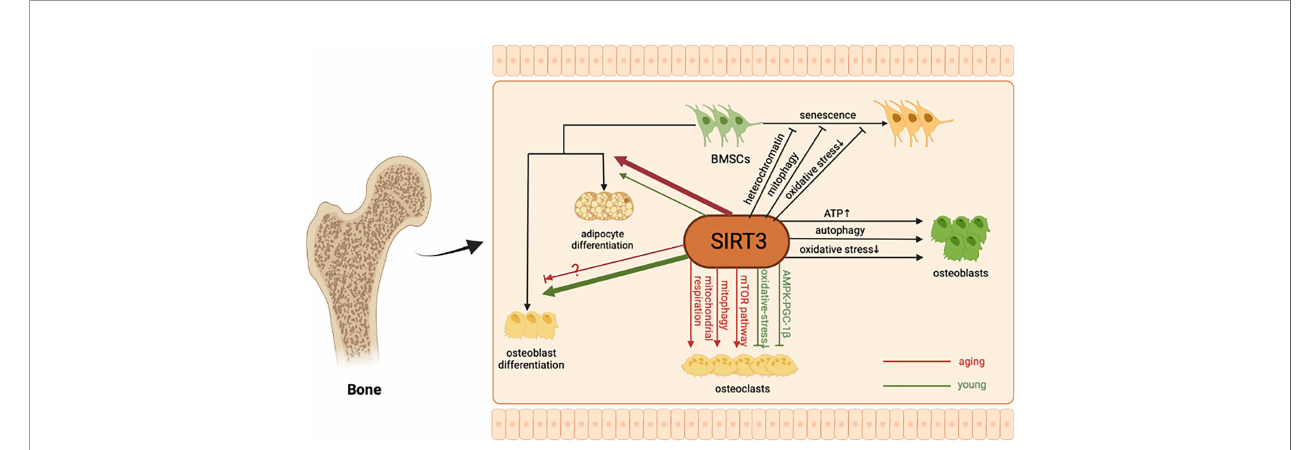
FIGURE 1 | The molecular mechanism of SIRT3 in bone remodeling. As a major mitochondrial protein deacetylase, SIRT3 can alleviate BMSCs senescence by regulating oxidative stress, mitophagy, and stabilizing heterochromatin. In addition, SIRT3 could protect osteoblasts and promote bone formation through multiple pathways. Regarding BMSCs differentiation and osteoclastogenesis, the regulatory role of SIRT3 may be